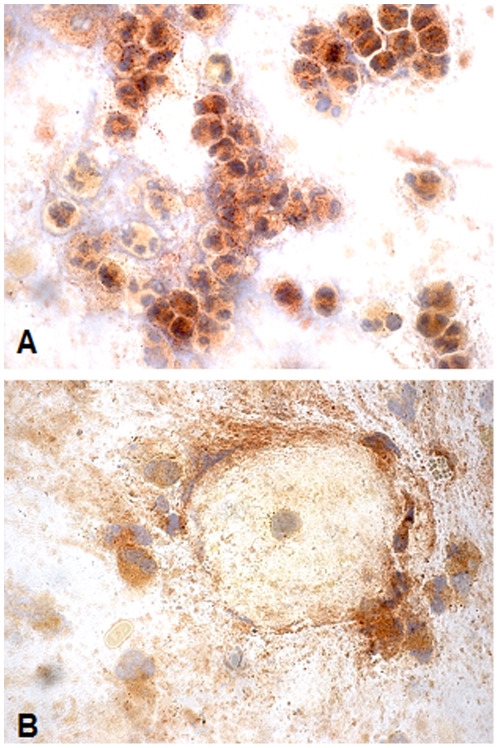
Cytochemical staining for GGT enzyme activity in sputum samples.(A) Neutrophils with different levels of GGT activity in sputum films of patients with cystic fibrosis. (B) GGT-negative epithelial cell surrounded by GGT-positive neutrophils is also shown. Magnification 100×.